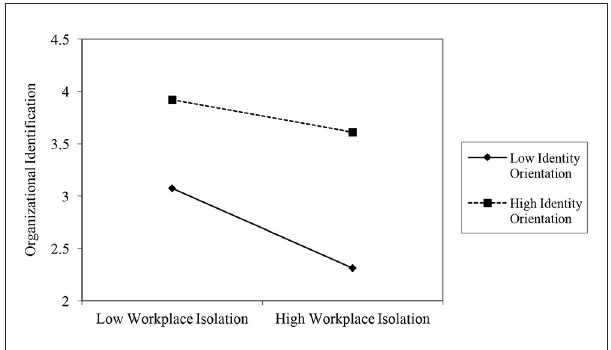
FIGURE2 The impact of the interaction between “workplace isolation” and identification orientation on organizational